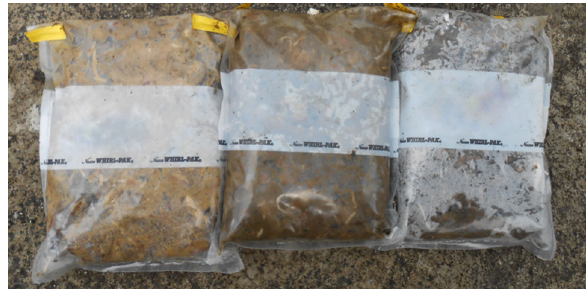
Fig. 4 Determination of colour and texture changes in 5 kg waste after 28 days of degradation